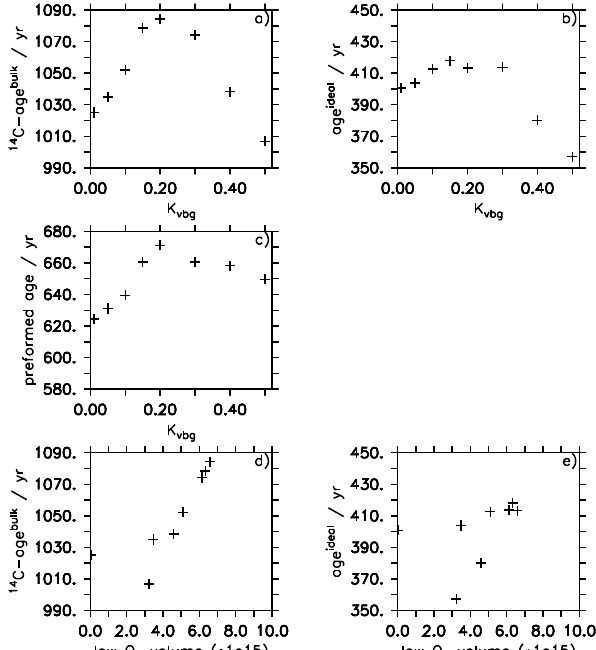
Figure 10. Sensitivity of ages of suboxic waters to vertical diffu- sivity ( K vbg ) in the UVIC model. (a) Bulk age, (b) ideal age and (c) preformed age. Scatter plots of bulk age (d) and ideal age (e) vs. volume of suboxic waters in the model